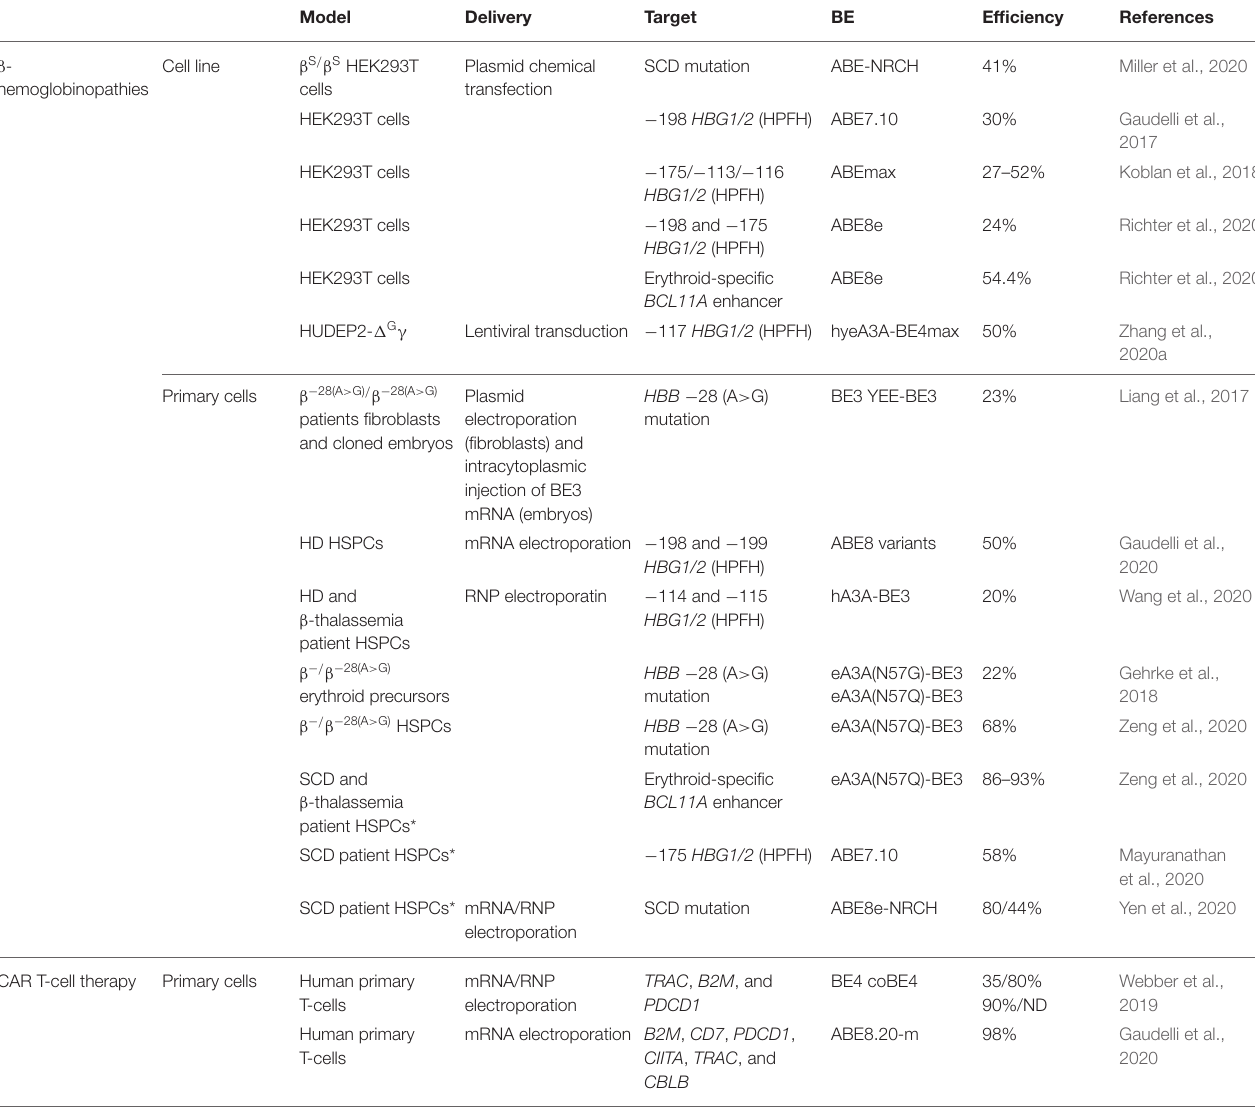
TABLE 1 | Base editing strategies for the treatment of blood